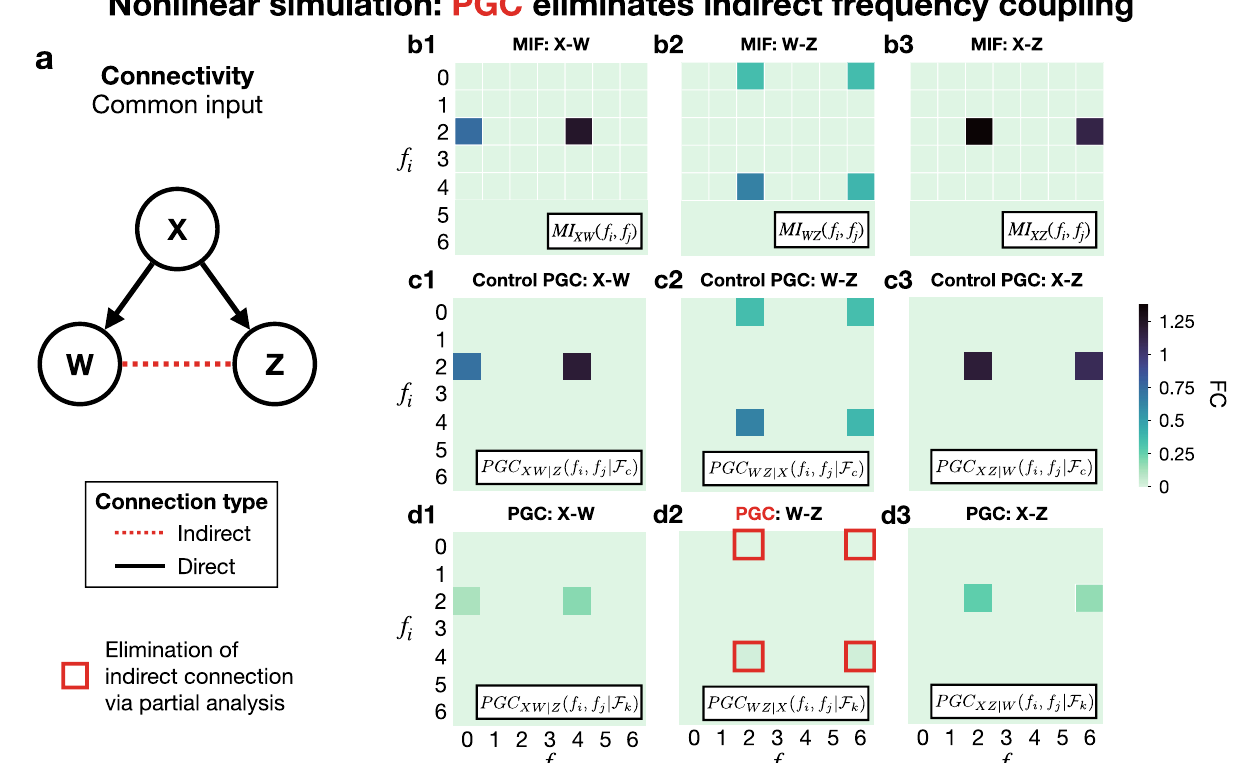
Figure 4. Nonlinear interactions between simulated processes resulting in direct and indirect coupling. ( a ) Diagram of cross-frequency coupling (CFC) between processes. Common input configuration (Fig. 1b) induces an indirect connection between W and Z . ( b ) Pairwise analyses of CFC between processes using MIF (7). ( b1 ) MIF between X and W . ( b2 ) MIF between W and Z , which ambiguously identified the indirect coupling for four different frequency pairings. ( b3 ) MIF between X and Z . ( c ) PGC conditioned on irrelevant frequencies 1 and 3 Hz (denoted as the set F c ) resulted in minimal changes. This analysis is referred to as control PGC, which serves as a contrast for the relevant conditioning performed in ( d ). ( c1 ) Control PGC between X and W . ( c2 ) Control PGC between W and Z . ( c3 ) Control PGC between X and Z . ( d ) PGC was then conditioned on relevant frequencies, denoted as the set F k , of the other process for each pair of processes. ( d1 ) PGC between X and W , which preserved the existence of direct coupling. ( d2 ) PGC between W and Z , which resulted in the elimination of all indirect coupling between these two nodes. ( d3 ) PGC between X and Z , which preserved the existence of direct coupling. Heatmaps generated via seaborn 48